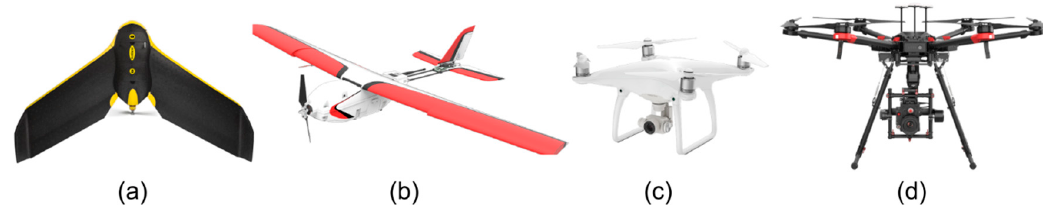
Figure 4. Some of the most used unmanned vehicle types: ( a ) fixed-wing, SenseFly eBee; ( b ) PrecisionHawk Lancaster; ( c ) rotary-wing, DJI Phantom 4 and ( d ) DJI Matrice 600